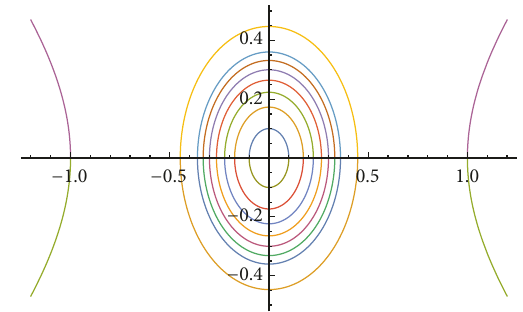
Figure 3: When 𝑐 = −2.09067 , an invariant algebraic curve 𝑥 2 − 2.09067𝑦 2 = 1 and eight small limit cycles.